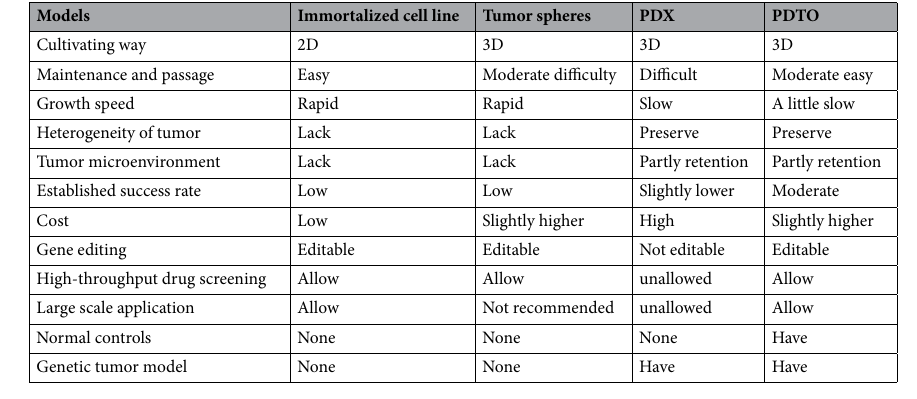
Table 1. Comparison of preclinical patient-derived tumor research